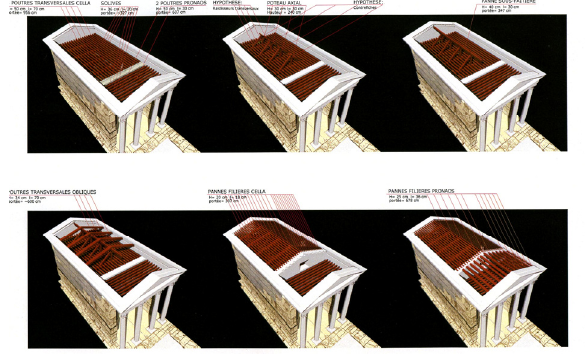
Figure 8. Architectural 3D model of the temple A of Hosn-Niha . © J. Yasmine; 2005.